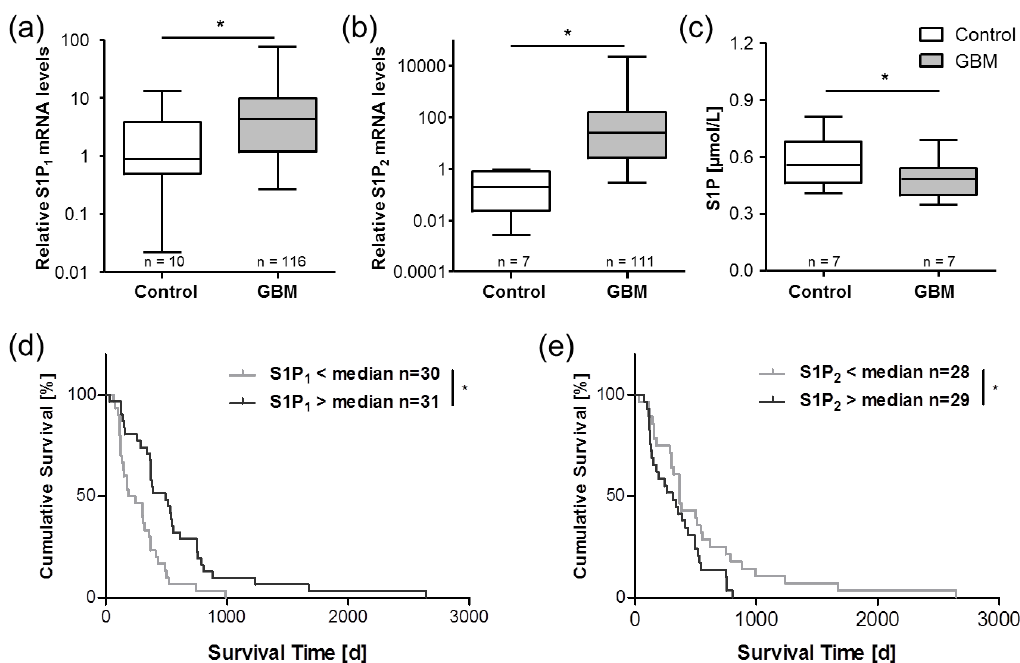
Figure 2. Expression of S1P receptors and circulating peripheral S1P levels are altered in GBM patients. In previous studies, we observed highly upregulated levels of mRNA for the S1P receptors S1P 1 ( a ) andS1P 2 ( b ) in GBM tissue [75]. The expression levels of both S1P receptors significantly correlated with the survival time of the respective GBM patients ( d , e ). In a later study, our data indicated reduced levels of S1P in platelet-rich plasma of GBM patients ( c ) [56]. These observations point towards a key role of S1P signaling system in the pathophysiology of GBM and are in agreement with studies from other groups [87,88]. Data are adapted from Bien-Möller et al. [75] and Marx et al. [56] and are shown as box plots representing the median as horizontal bars as well as the 5th and 95th percentile. * p <